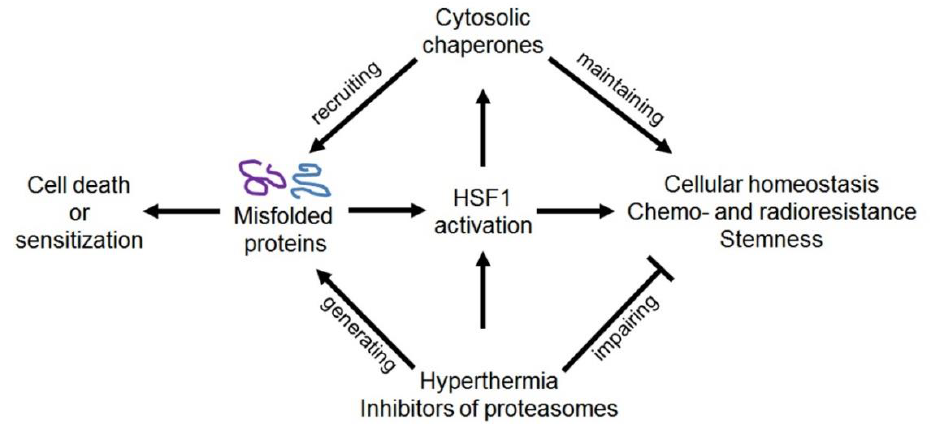
Figure 6. A scheme showing the duality of the action of hyperthermia or proteasome inhibitors on CSCs. The treatment-induced intracellular accumulation of misfolded proteins depletes the cytosolic pool of chaperones, so that the chaperone-dependent maintenance of the cell viability and cancer stemness is ceased, which may yield the elimination or sensitization of treated CSCs. However, the excess misfolded proteins activate HSF1, which triggers HSP expression and then the new chaperones (HSPs) will promote the survival and recovery of the treated CSCs.